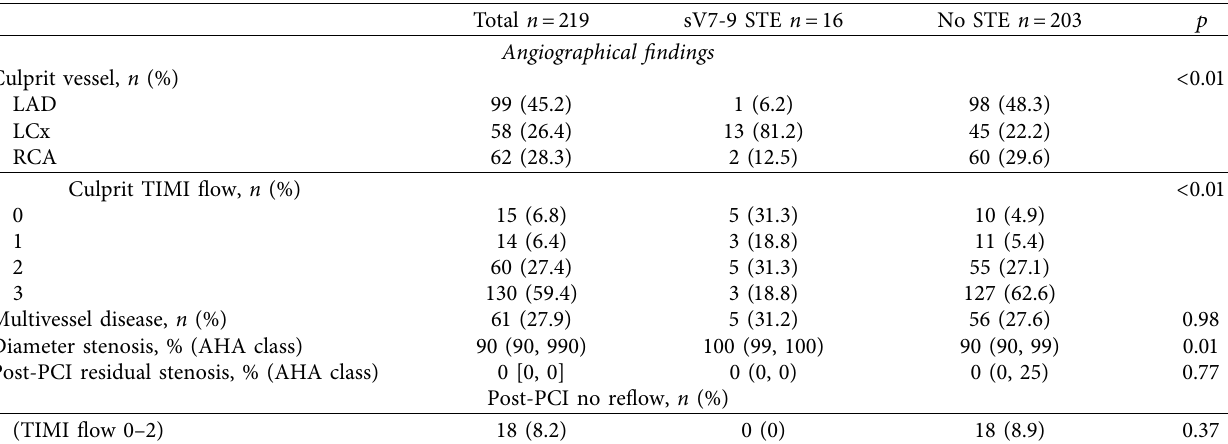
Table 2: Angiographical